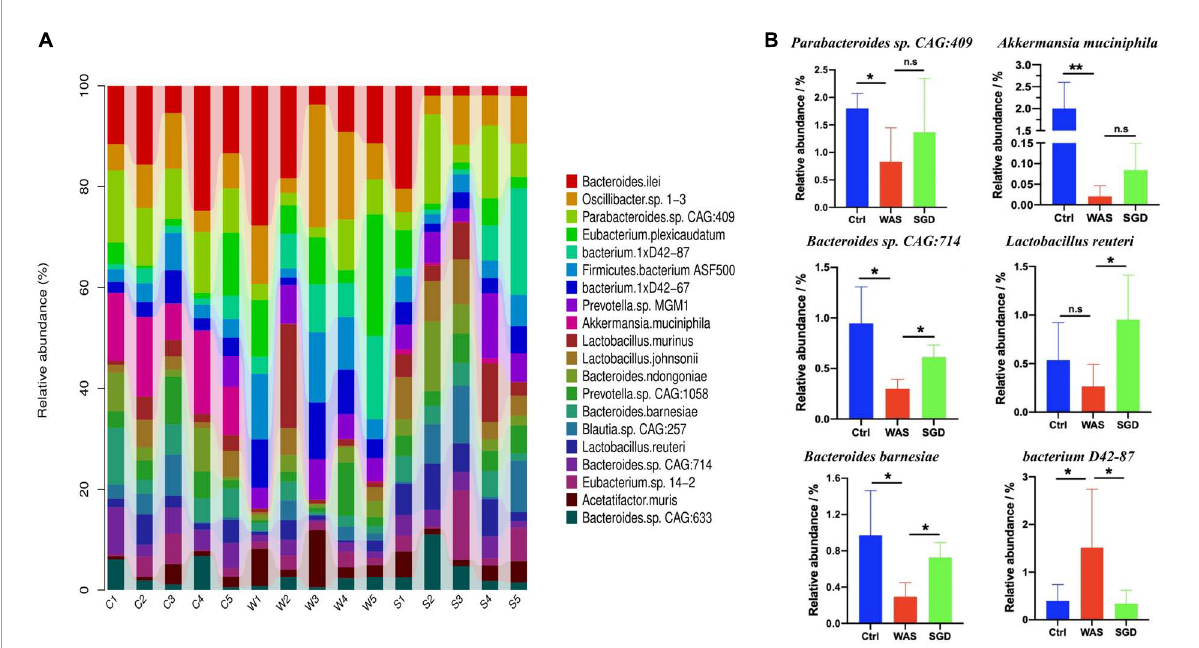
FIGURE4 Effects of SGD on the intestinal microbiota of IBS-D model rats at the species level. (A) SGD treatment changed the intestinal microbiota at the species level. (B) Compared with the control group, the relative abundance of Parabacteroides sp. CAG: 409 , Akkermansia muciniphila, Bacteroides sp. CAG : 714 and Bacteroides barnesiae decreased, and the relative abundance of bacterium 1xD42-87 increased in the WAS group; compared with the WAS group, the relative abundance of Bacteroides sp. CAG: 714 , Lactobacillus reuteri , and Bacteroides barnesiae increased and the relative abundance of bacterium 1xD42-87 decreased in the SGD group. Control group; WAS group; SGD group ( n = 5 per group) (* P < 0.05, ** P <